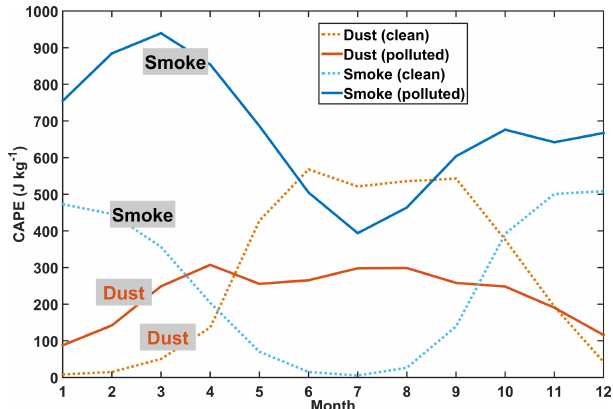
Figure 3. Seasonal variations in CAPE under relatively clean and polluted conditions in the dust- and smoke-dominant regions. Clean (polluted) cases are defined as those CAPE values corresponding to the lowest (highest) third of the aerosol optical depth (AOD) range (AOD ∈ (0, 1)).